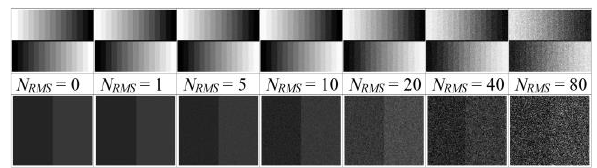
Figure 3 . Test sample images, created for the initial verification of the noise level estimation algorithm based on harmonic analysis; the upper row – the overall image’s view, the bottom raw – an enlarged part of each image